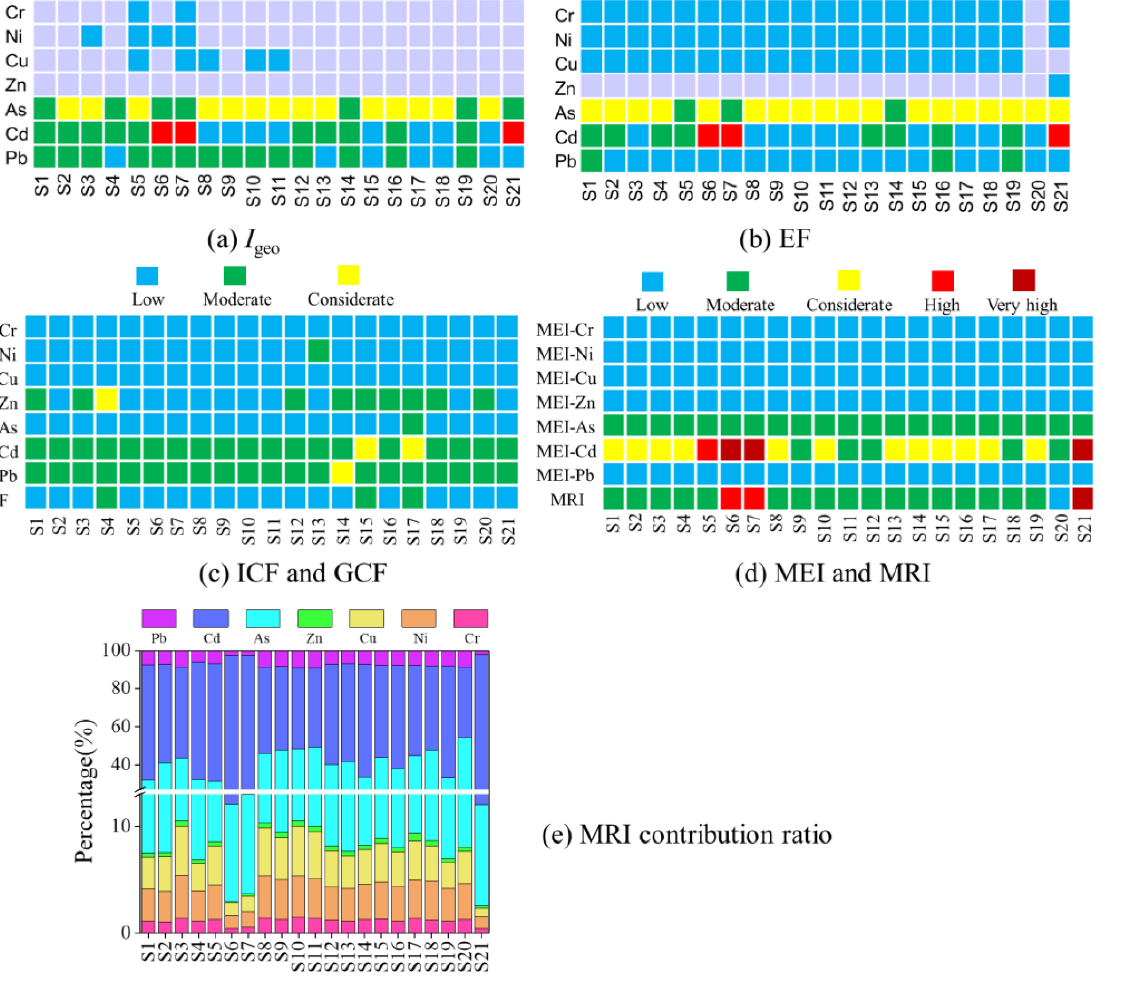
Figure 4. Contamination assessments of PTEs in sediments of the Wuliangsuhai wetland by I geo , EF, ICF and MRI.